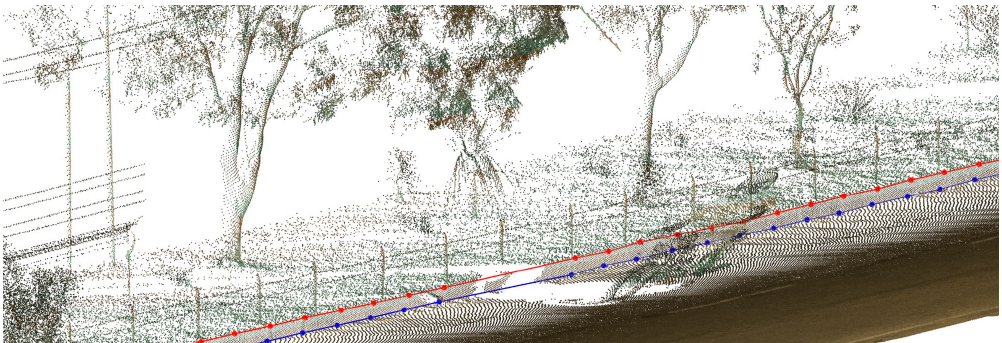
Figure 14. Break line extraction sample.